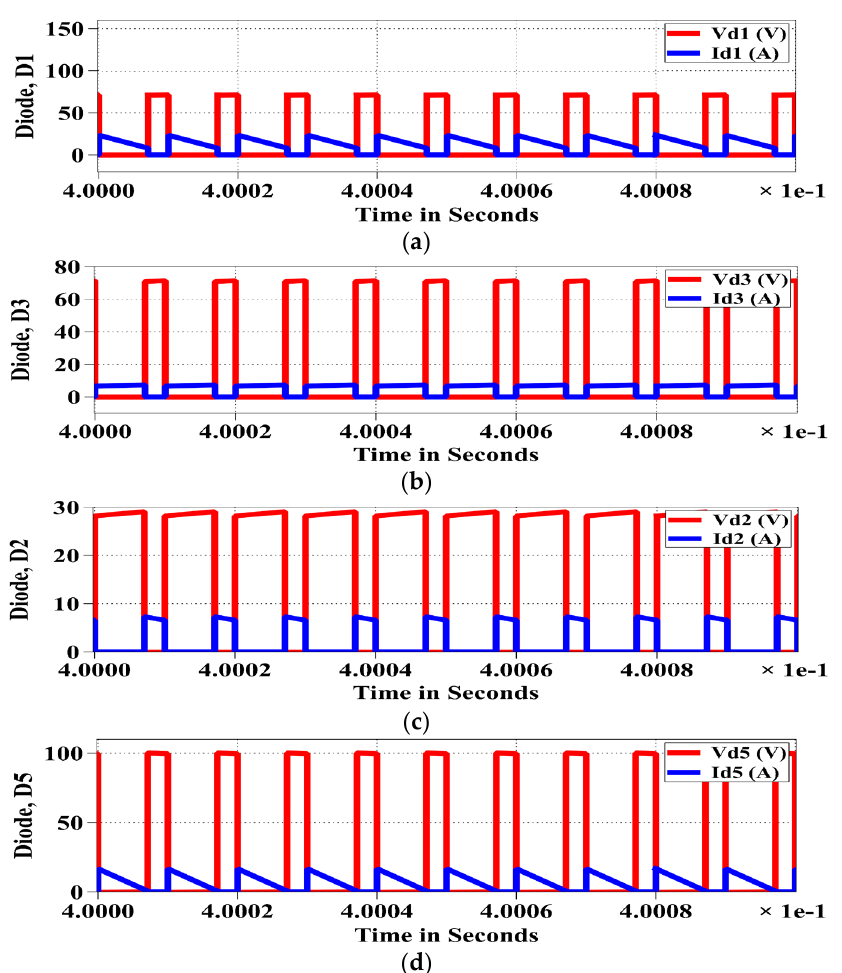
Figure 7. Current and voltage stress waveform: ( a ) Diode, D 1 ; ( b ) Diode, D 3 ; ( c ) Diode, D 2 ; ( d ) Diode, D 5 .